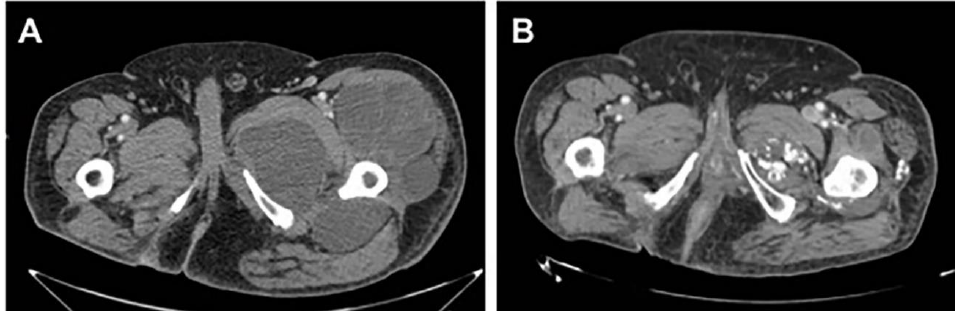
Figure 2. RECIST partial response in a 73-year-old man with a round-cell myxoid liposarcoma. The patient received trabectedin plus RT (39 Gy in 13 fractions) in first line, as he had contraindication to anthracyclines and ifosfamide due to cardiac problems. ( A ) Baseline study (April 2017). ( B ) Long-lasting partial response (June 2019).